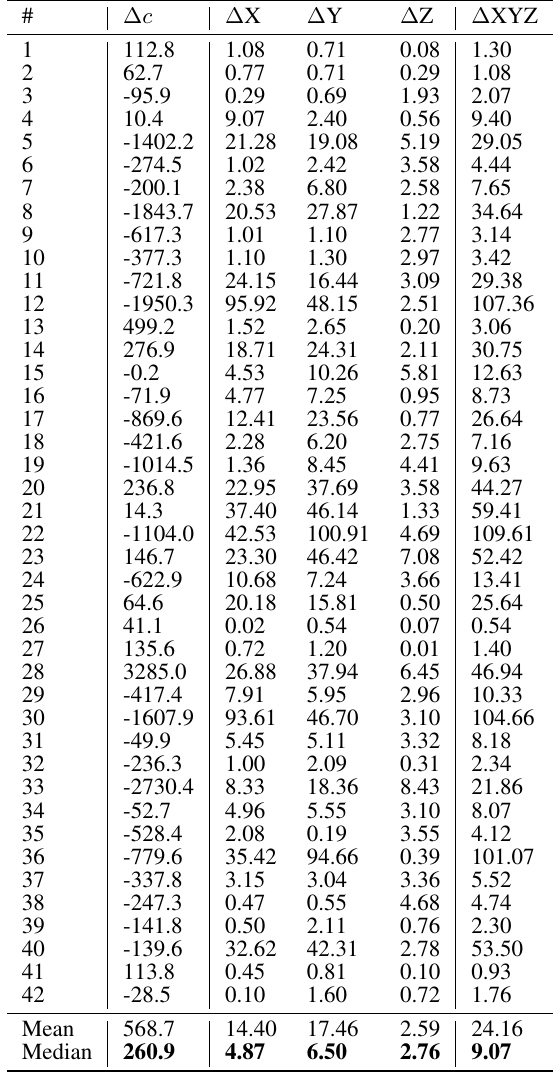
Table 3. Difference of the principal distance in pixels and coordinate differences in meters between 42 reference and estimated camera poses in all coordinate